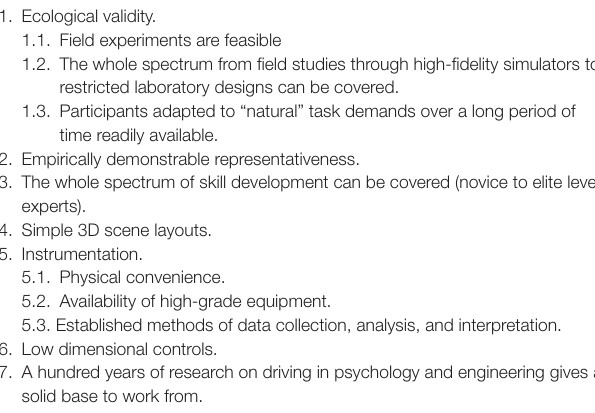
TABLE 1 | From an experimental and modeling point of view, gaze strategies in driving are a particularly attractive “model behavior” for understanding visual guidance in ecologically representative